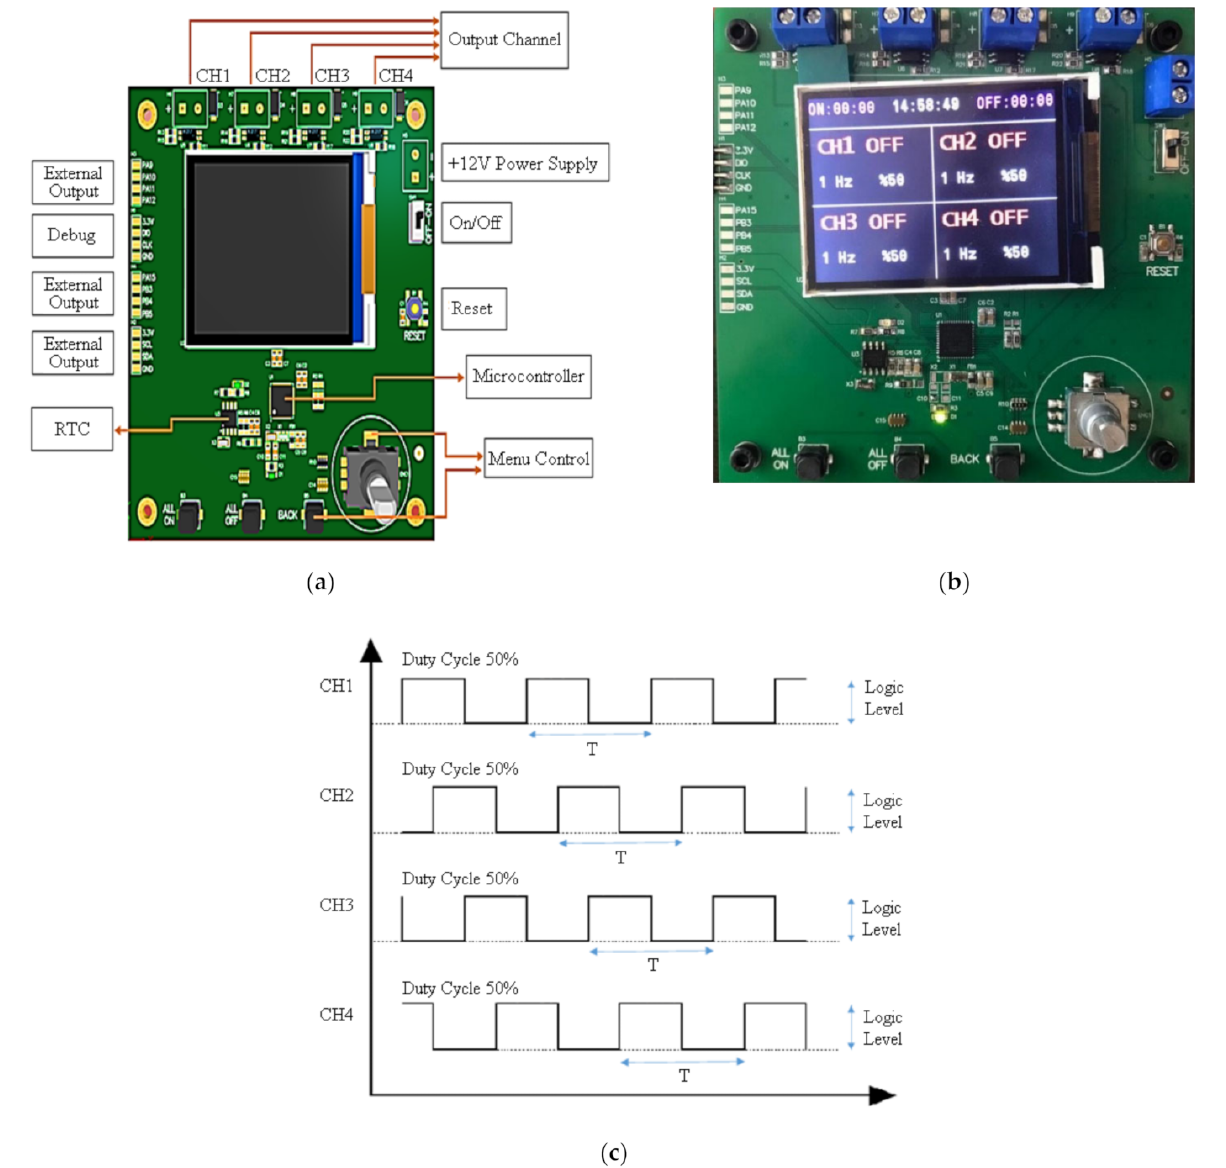
Figure 1. Electrostatic cleaner card: ( a ) Controller card and I/O signals, ( b ) Display, ( c )